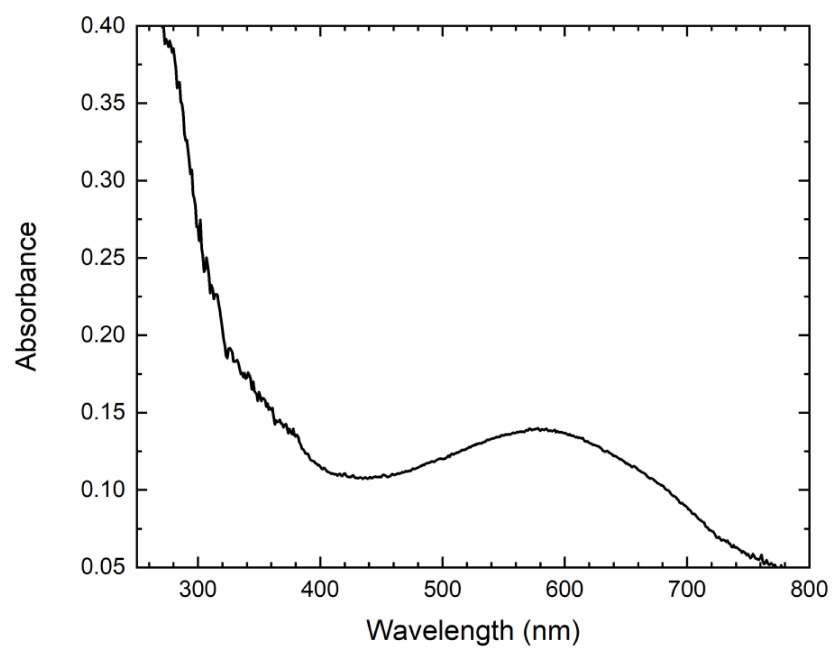
Figure 22. Absorption spectrum of the SO 32— -bearing analogue of marinellite (a mixture of Sample 13a and Sample 13b).